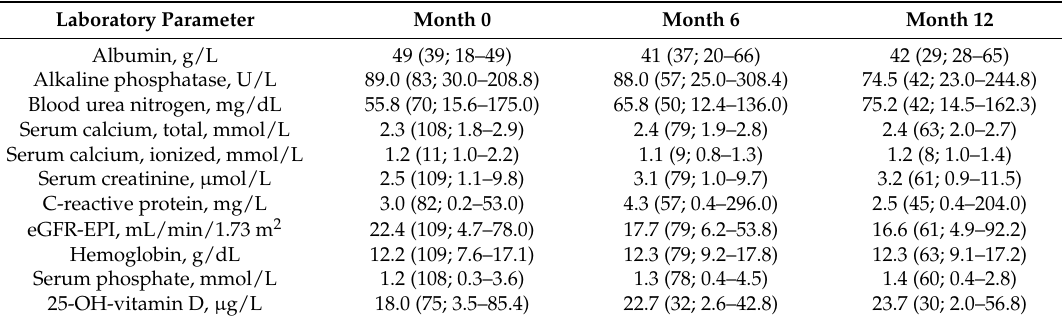
Table 12. Relevant laboratory data from predialysis patients *.